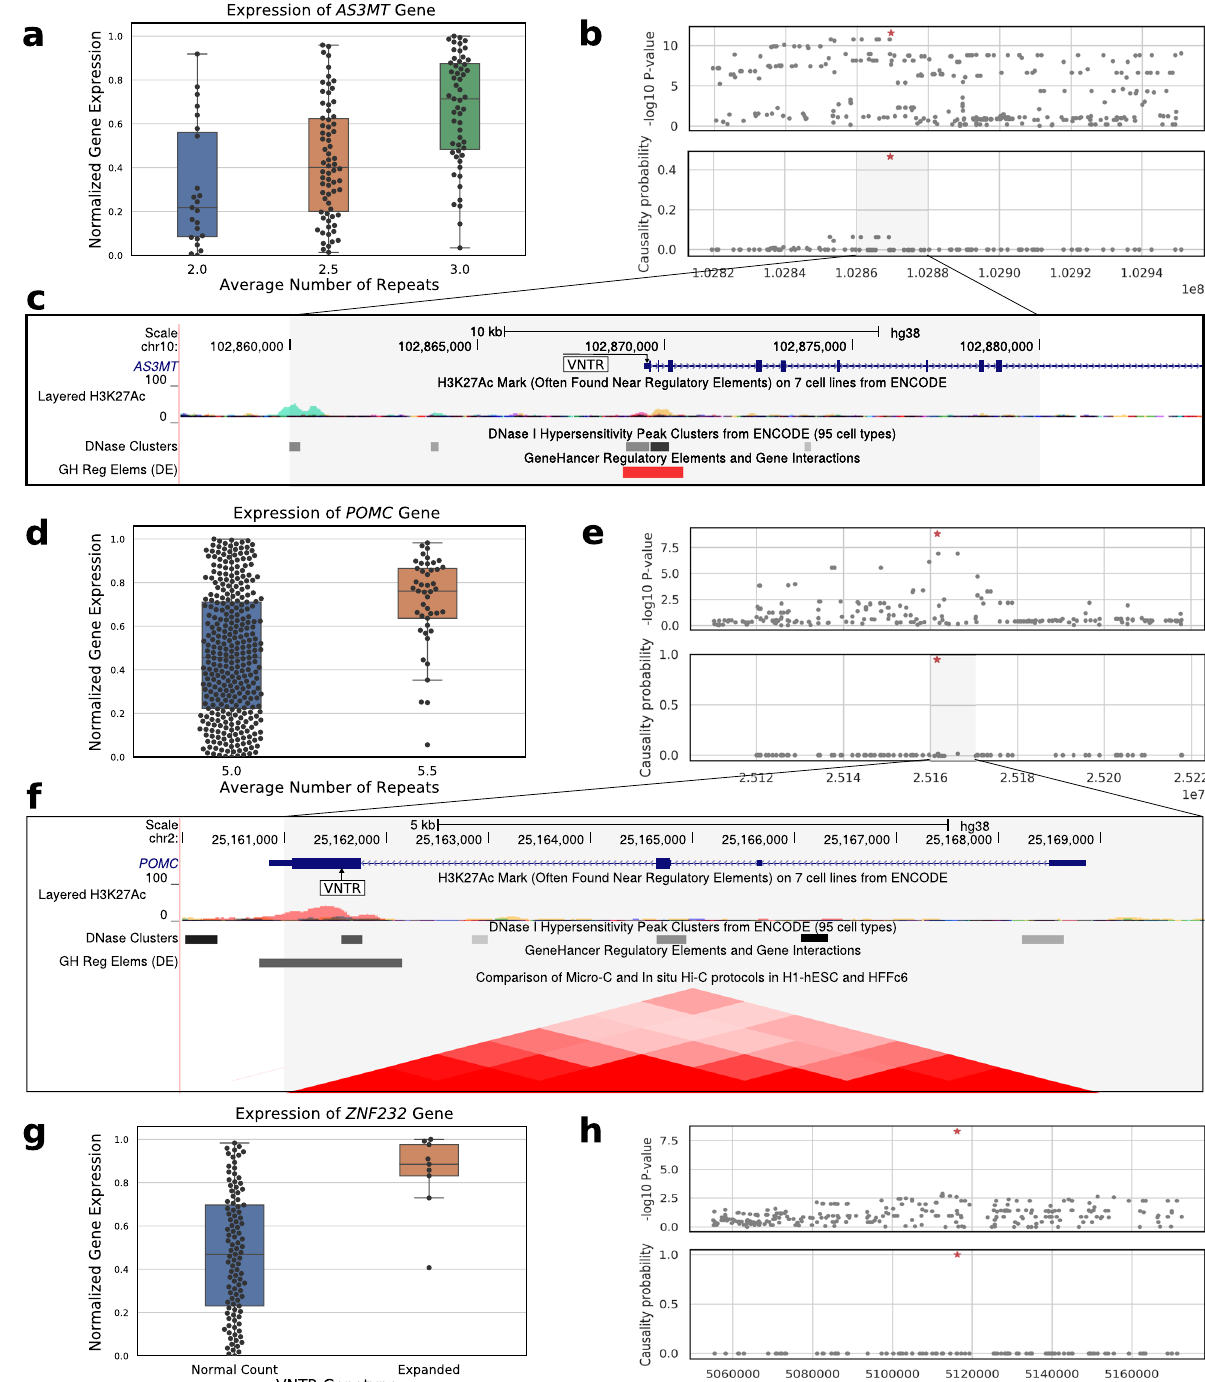
Fig. 3 Effect of VNTR genotypes on mediating gene expression. a Association of AS3MT VNTR genotype with gene expression in brain cortex ( n = 148 samples, Fisher ’ s two-sided P : 2.78× 10 − 12 ). Box plots display the median, 25th and 75th percentiles. b Association with gene expression (upper panel) and CAVIAR causality probability of proximal SNPs — all SNPs in 100kbp window on either side of the AS3MT VNTR (red-star). c Location of AS3MT VNTR relative to known regulatory elements. d , e Association with gene expression of the POMC VNTR ( n = 378 samples, Fisher ’ s two-sided P : 1.53 × 10 − 9 ) and its causality probability relative to proximal SNPs. Box plots display the median, 25th and 75th percentiles. f Location of POMC VNTR relative to other regulatory regions and its spatial proximity with the promoter region revealed via Hi-C. g , h Association with gene expression of the ZNF232 VNTR ( n = 114 samples, Fisher ’ s two-sided P : 5.47× 10 − 9 ) and its causality score relative to proximal SNPs. Box plots display the median, 25th and 75th percentiles. Source data are provided as a Source Data fi